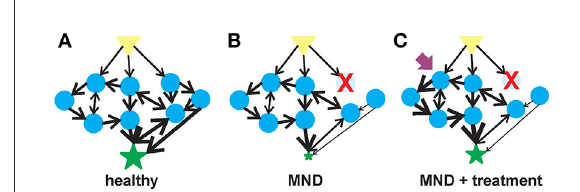
FIGURE1 Flow of information in a complex system in motor neuron health, disease and therapeutic intervention. (A) In a healthy motor unit–lower motor neurons, interneurons and the muscle, activation of a signal (yellow triangle) leads to the stimulation of multiple agents (blue circles) that are interconnected into collection of aggregates known as meta-agents to form a hierarchical higher-order structure. The aggregates interact non-linearly to elicit a response (green star) whose behavior is quantitatively different from the individual agents. (B) Upon the loss of or alteration in an agent (in this case, an early-onset MND represented by the red X), the behavior of the aggregated meta-agents is altered and the flow of information is blunted. (C) A therapeutic agent (purple arrow) can activate one of the undamaged agents which would, in turn, activate the unaffected parts of the hierarchical aggregate and partially compensate for the diminished flow of information resulting from the altered